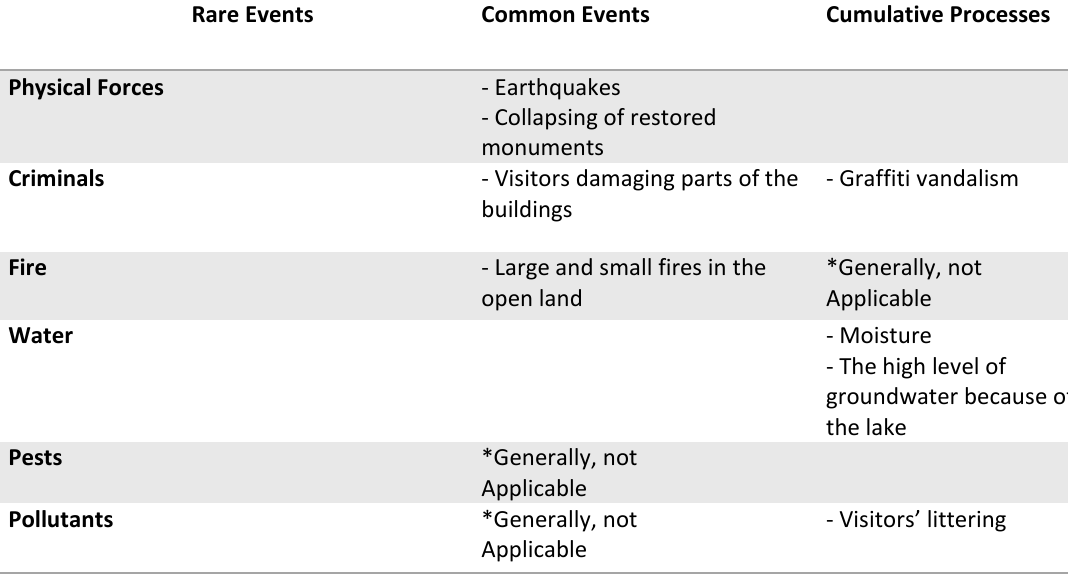
Table 2 Risk agents in the Old Town of Van considering the types of